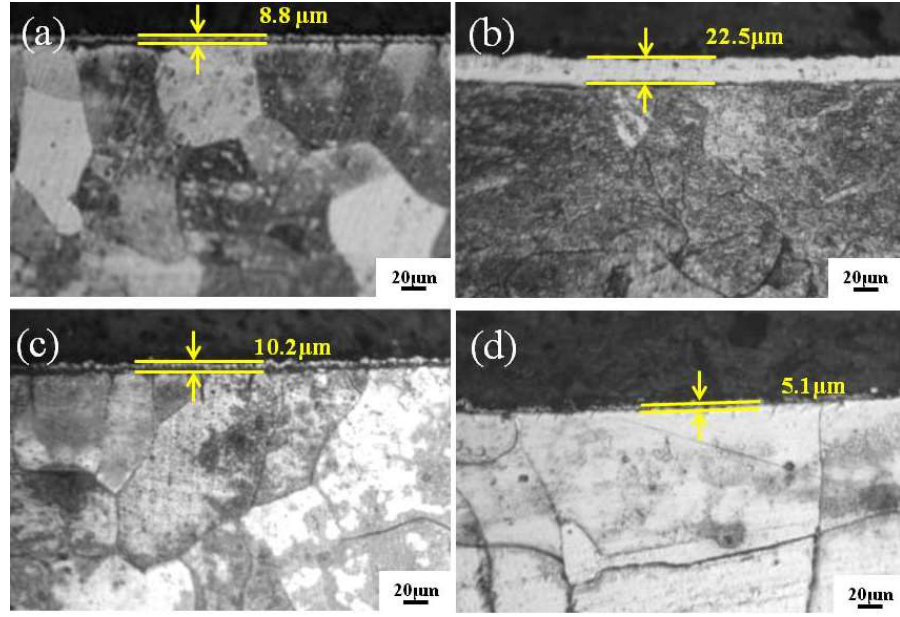
Figure 5. The cross-sectional MM images of Fe-Al-Cr alloyed layers under different gas pressures: ( a ) 25 Pa; ( b ) 35 Pa; ( c ) 45 Pa; ( d ) 55 Pa.